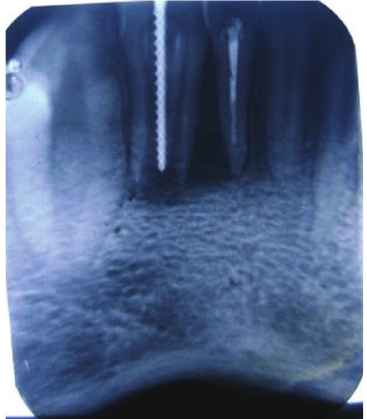
Figure 5: Radiograph showing the whole removal of parts of invagination and rudimentary canal in relation to 32 and metapex dressing in 31.